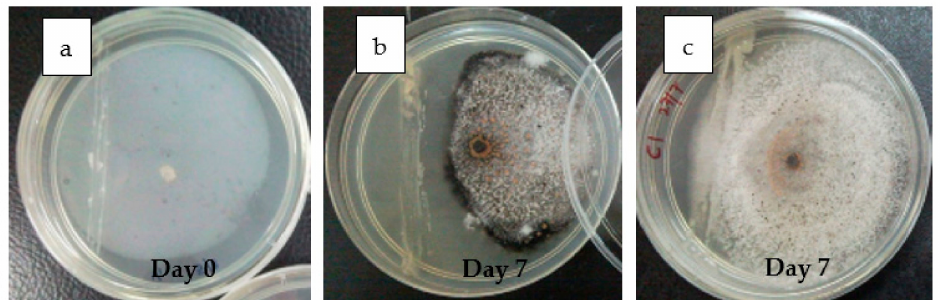
Figure 1. Radial growth of C. gloeosporioides co-cultured with antagonist yeast after seven days at 28 ± 2 ◦ C; ( a , b ) C. gloeosporioides co-cultured with LP010 and ( c ) C. gloeosporioides co-cultured with